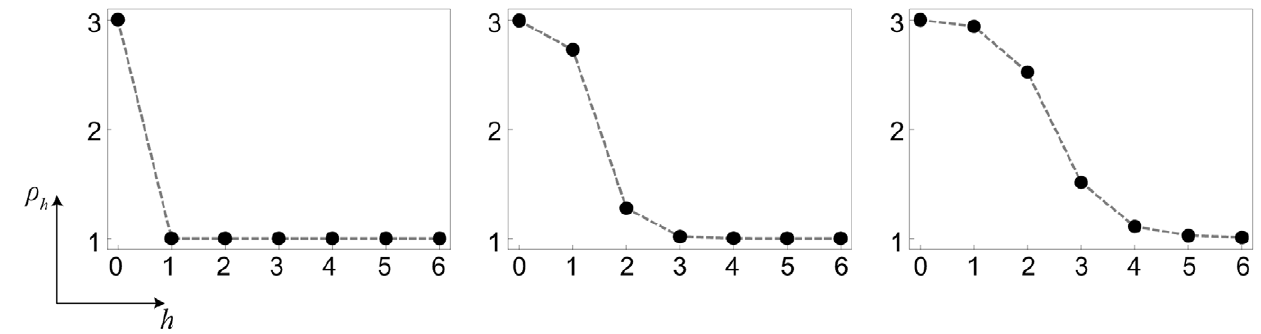
Figure 1. Traveling front in an Erdo¨s-Re´nyi network. The network size is N ~ 500 and the mean degree is S k T ~ 7 . Three consequent snapshots of activity patterns at times t ~ 0,10,21 are shown. Quantity r h is the average value of the activator density u in the subset of network nodes located